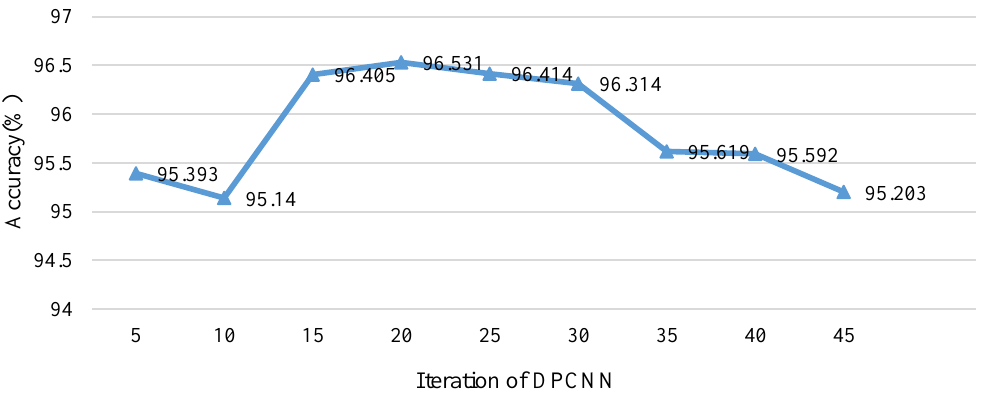
Figure 11. Relationship between Iteration of DPCNN and accuracy.